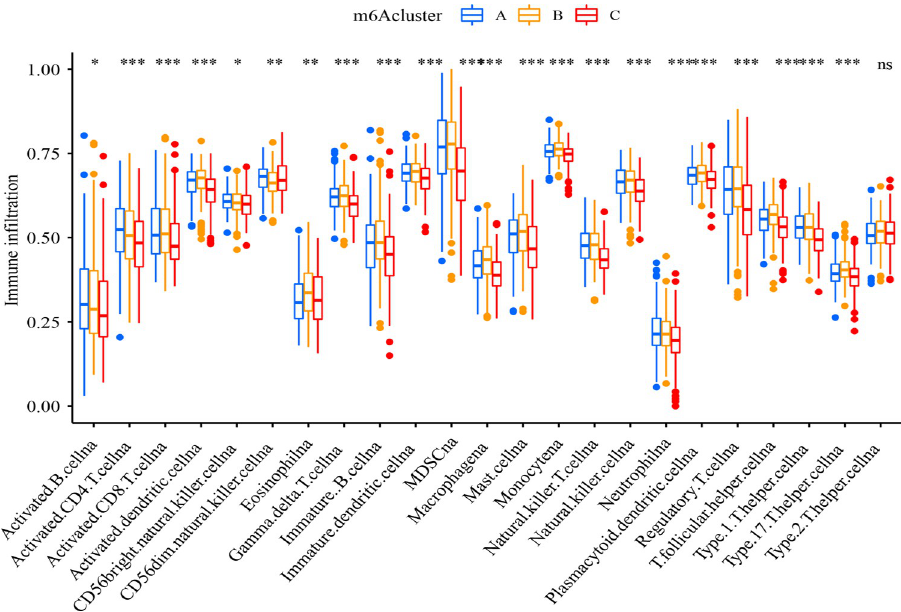
Fig 5. Immune cell differential analysis (ssGSEA). Horizontal coordinates indicate immune infiltrating cells, vertical coordinates indicate immune infiltration abundance, blue boxes indicate cluster A, yellow boxes indicate cluster B, and red boxes indicate cluster C. � P < 0.05, � � P < 0.01, and � � � P <